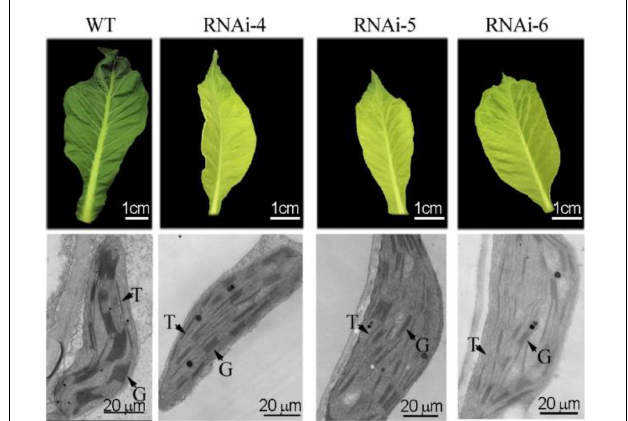
FIGURE 4 | Ultrastructural observation of green and chlorotic leaves from non-transgenic WT and transgenic tobaccos with suppressed NtClpP3 , respectively. T, thylakoid; G,